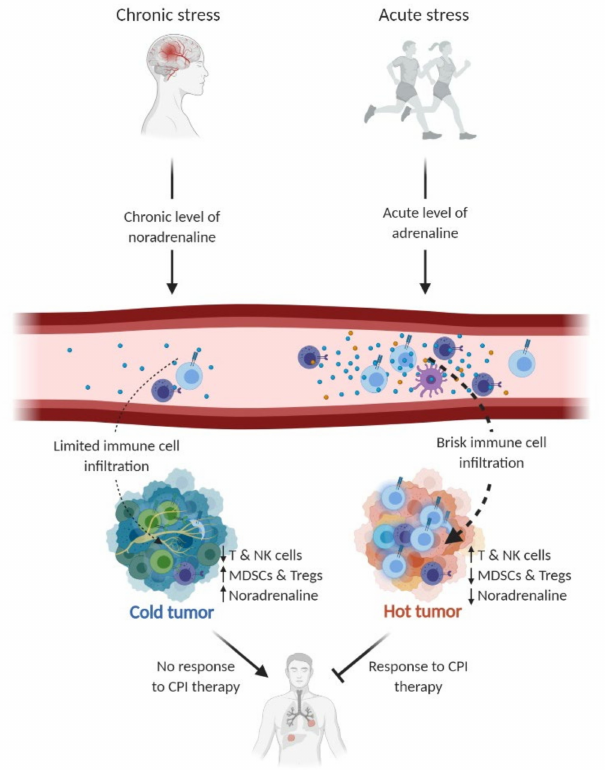
Figure 1. The dual effect of the catecholamines noradrenaline and adrenaline. Chronic stress leads to an increased baseline level of noradrenaline in the circulation and intratumorally, contributing to tumor progression and possibly suppression of anti-cancer immune responses. Conversely, acute stress (e.g., exercise) results in elevated adrenaline levels in the circulation, followed by instant mobilization and redistribution of immune cells. Preclinical studies have shown that exercise-induced mobilization increases tumor infiltration of immune cells, thus holding the potential of modulating the tumor microenvironment by converting it from a cold to a hot tumor. Consequently, this could increase anti-tumor immune responses and improve responses to checkpoint inhibitory (CPI)